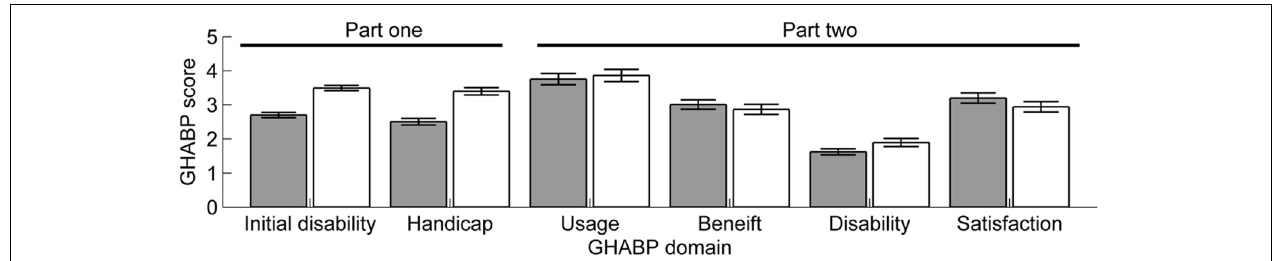
FIGURE 2 | Mean GHABP scores for pre-defined (gray bars) and self-nominated (white bars) scenarios. Error bars show ± 1 standard error of the mean.